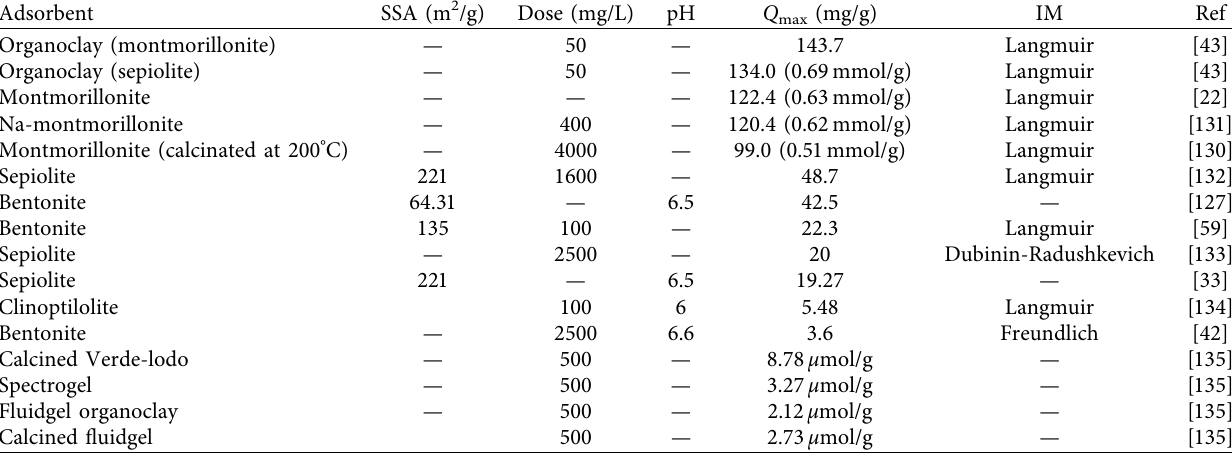
Table 9: Summary of characteristics of aluminosilicate mineral adsorbents and conditions of the adsorption process.